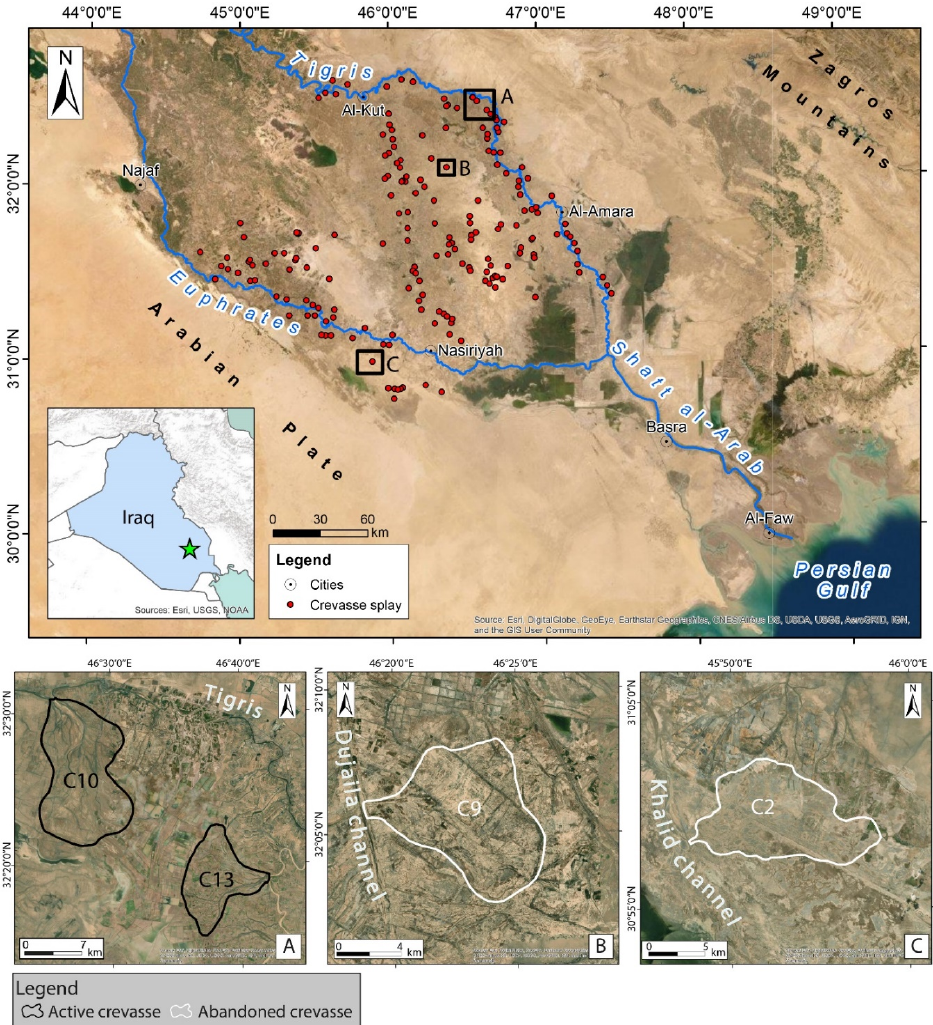
Figure 1. Satellite nadiral view of the study area from TerraColor satellite imagery and distribution of the crevasse splays in the investigated area. Black rectangles indicate the floodplain sectors where the crevasse splays reported and discussed in this work. ( A ) active crevasse splays along the present Tigris fluvial system (C10 and C13); ( B ) abandoned crevasse splay along an ancient watercourse (C9); ( C ) abandoned crevasse splay along an ancient watercourse belonging to the Euphrates fluvial system (C2).